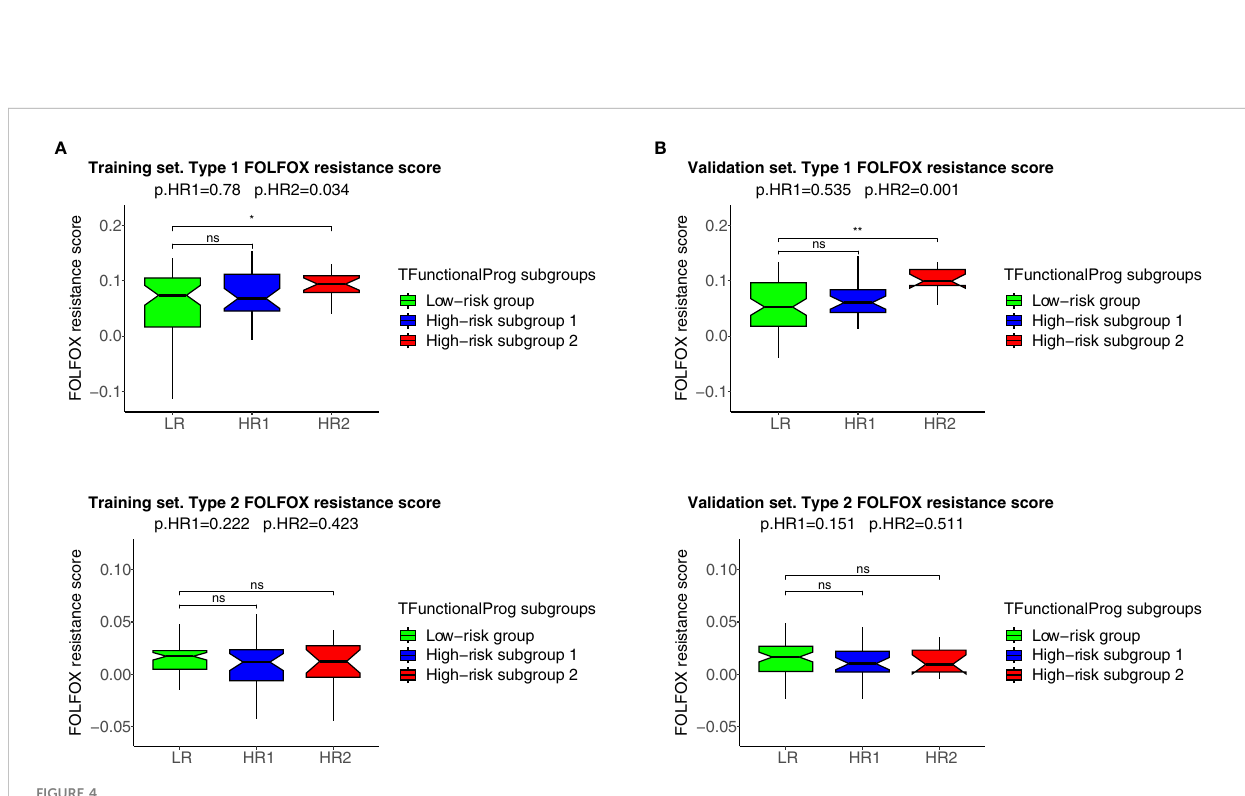
FIGURE 4 FOLFOX chemotherapy resistance scores of the TFunctionalProg low-risk group (green, LR), TFunctionalProg high-risk subgroup 1 (blue, HR1) and TFunctionalProg high-risk subgroup 2 (red, HR2). Type 1 FOLFOX resistance scores are plotted in (1A) (training set) and (1B) (validation set), and type 2 FOLFOX resistance scores are plotted in (2A) (training set) and (2B) (validation set). The signi fi cance levels of pairwise comparisons against FOLFOX resistance scores of stage II CRC patients in the TFunctionalProg low-risk subgroup (green, LR) as the reference group are shown in the fi gure (ns p>0.05, * p < 0.05, ** p < 0.01). In the title, the fi rst p-value p.HR1 is the comparison between the FOLFOX resistance scores of stage II CRC patients in the TFunctionalProg high-risk subgroup 1 (blue, HR1) and the FOLFOX resistance scores of the other stage II CRC patients, and the second p-value p.HR2 is the comparison between the FOLFOX resistance scores of stage II CRC patients in the TFunctionalProg high-risk subgroup 2 (red, HR2) and the FOLFOX resistance scores of the other stage II CRC patients. Patients in the TFunctionalProg high-risk subgroup 2 (HR2) showed consistently high type 1 FOLFOX resistance scores in both the training set and validation set (p.training=0.034, p.validation=0.001). The resistance to chemotherapy in the subgroups of high-risk stage II CRC explains why adjuvant chemotherapy only showed a minimal incremental bene fi t in stage II